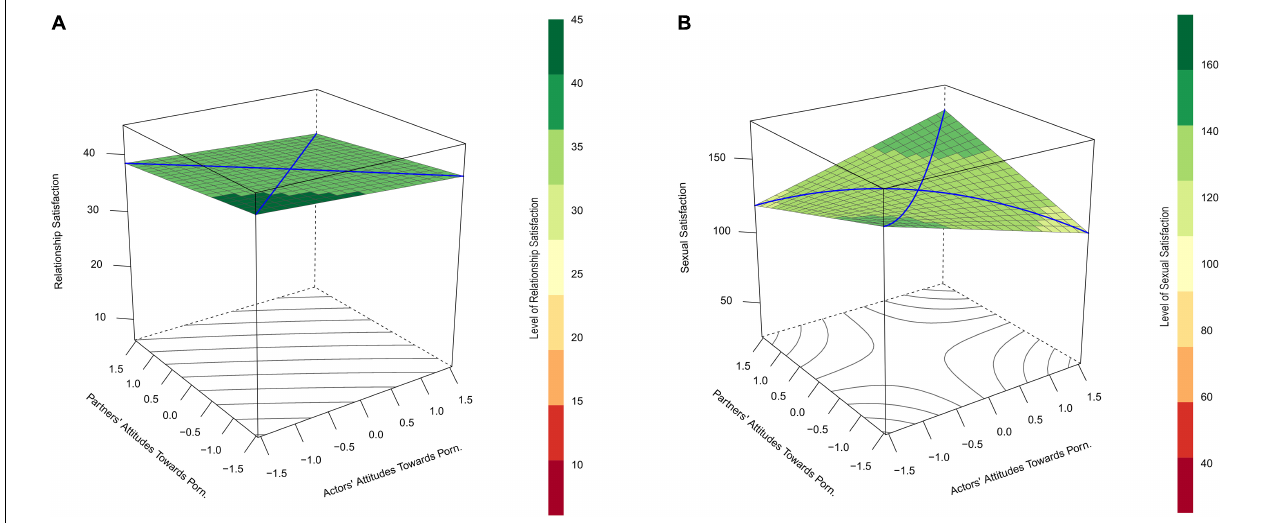
FIGURE 3 | (A) Depicts predicted relationship satisfaction (vertical axis) as a function of actors’ ( x -axis) and partners’ ( y -axis) attitudes toward using pornography themselves and the interaction between these variables in Study 2. (B) Does the same for the prediction of sexual satisfaction. In (A) , the lack of significant interaction results in a flat prediction surface where partners with dissimilar attitudes toward pornography are not notably lower in relationship satisfaction than partners who are more similar in their attitudes. In (B) , sexual satisfaction scores tended to be lowest in cases in which couple members were most dissimilar in their attitudes toward pornography (left- and right-most corners of the plots). According to regions of significance tests, participants’ attitudes toward using pornography themselves were negatively related to their own sexual satisfaction if their partners indicated any degree of dislike of pornography (partners’ attitudes toward pornography use < –0.36) but positively related to their sexual satisfaction when their partners indicated agreement or strong agreement with personally enjoying pornography (partners’ attitudes toward pornography use > 0.68).